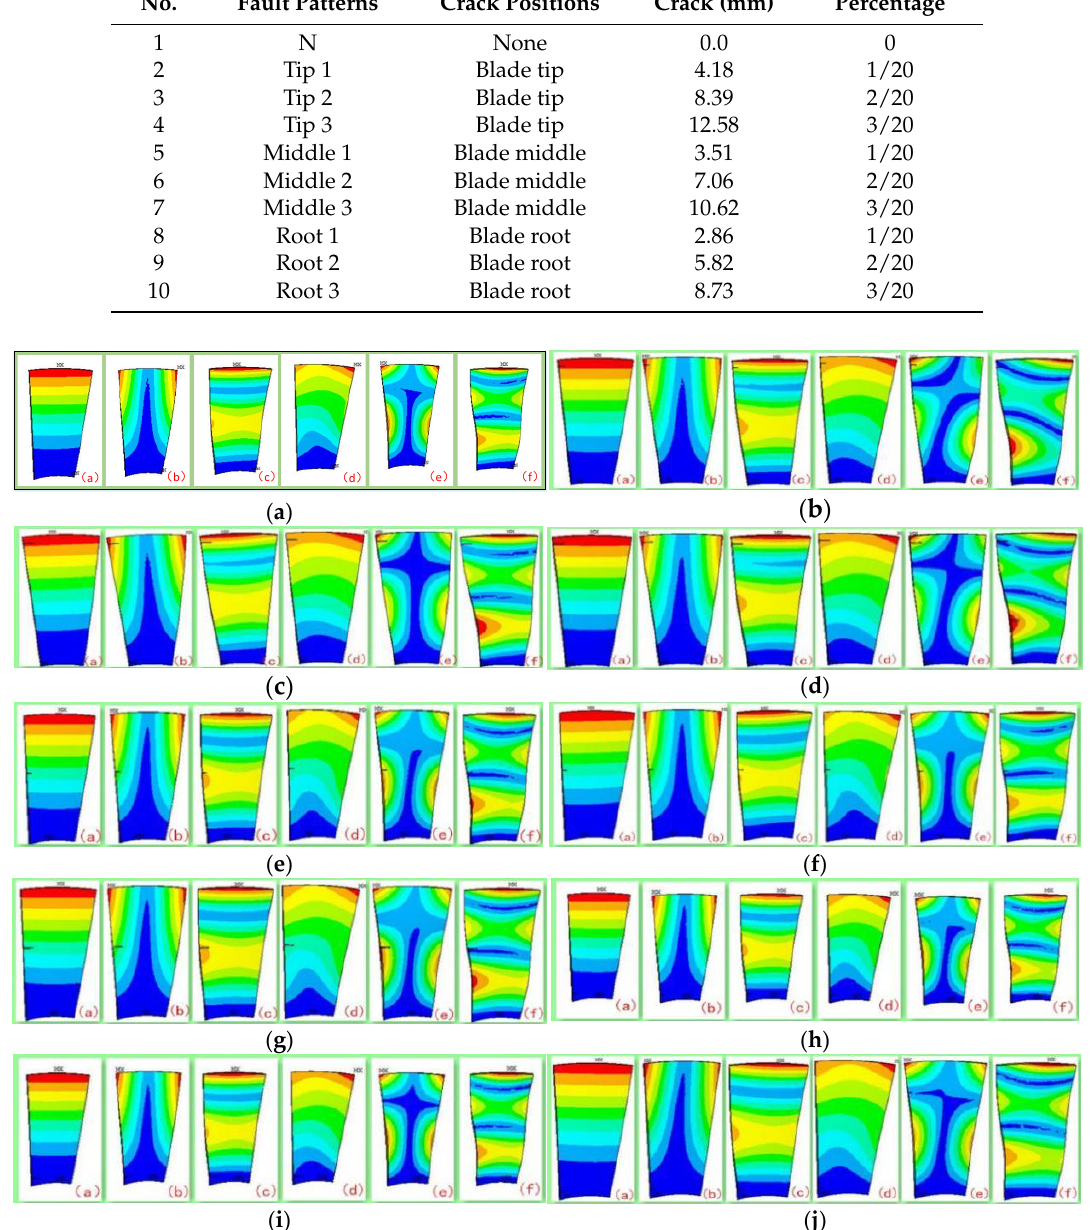
Figure 3. Blade modal shapes. ( a ) Flawless state (N); ( b ) Blade tip crack (Tip 1); ( c ) Blade tip crack (Tip 2); ( d ) Blade tip crack (Tip 3); ( e ) Blade middle crack (Middle 1); ( f ) Blade middle crack (Middle 2); ( g ) Blade middle crack (Middle 3); ( h ) Blade root crack (Root 1); ( i ) Blade root crack (Root 2); and ( j ) Blade root crack (Root 3).